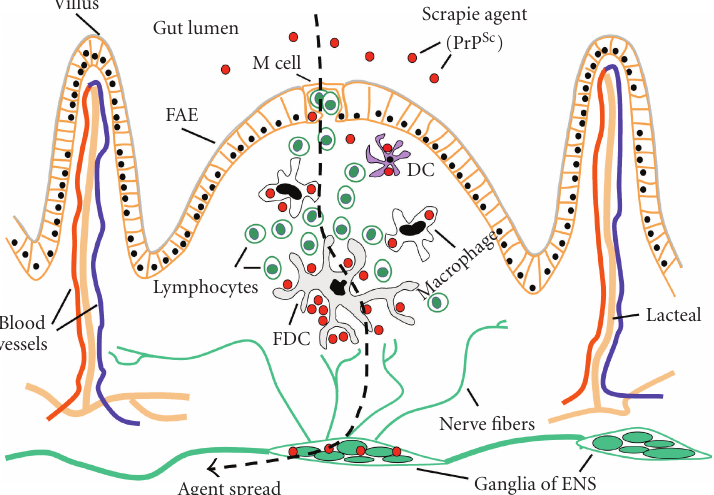
Figure 2: Diagrammatic representation of the possible pathways of absorption of TSE agents from the gut lumen and their transport to the ENS. Permission was obtained for reproducing this figure originally published in